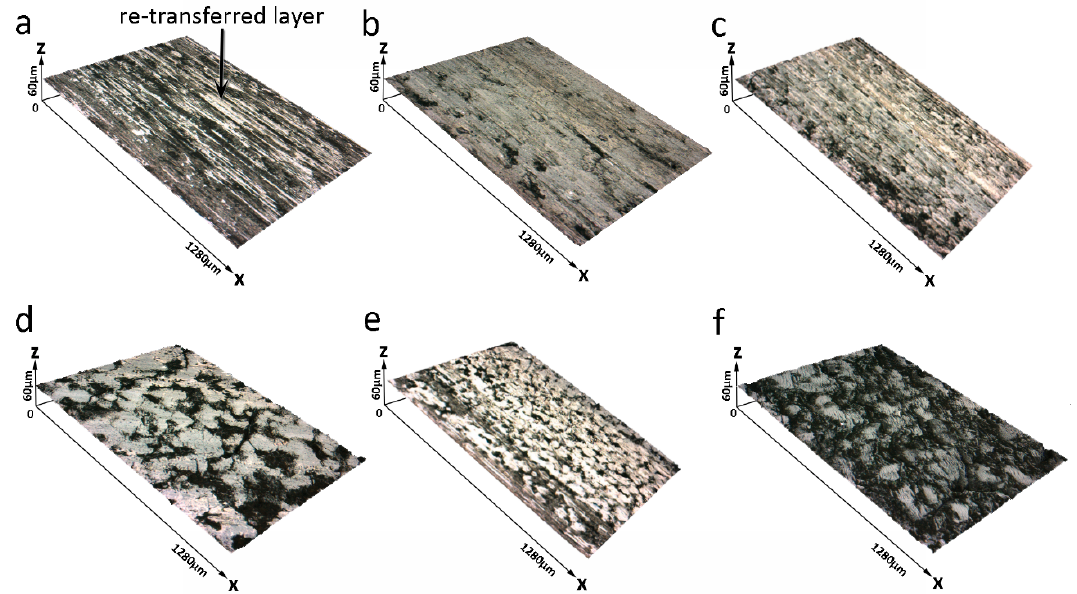
Figure 4. Three-dimensional (3-D) images of friction surface of the PF friction material at different friction speeds at 0.51 MPa: ( a ) 3.1 m/s, ( b ) 7.9 m/s, ( c ) 15.7 m/s, ( d ) 23.6 m/s, ( e ) 31.4 m/s, ( f ) 47.1 m/s.